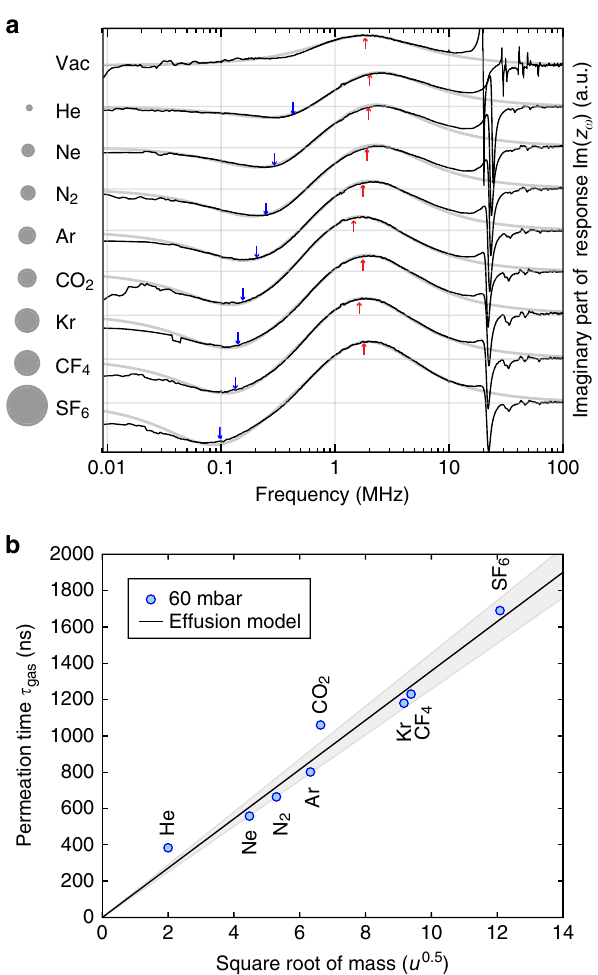
Fig. 3 Dependence of τ gas on gas molar mass. a Measurements performed in high vacuum and in various gases at P = 60 mbar on a micro drum with a 400 nm pore. Eq. (5) (grey line) is fi tted to the imaginary part of the measurement data (black line) and the red and blue arrows indicate the values obtained for τ th and τ gas , respectively. The areas of the circles represent the relative mass of the gas particles. b The permeation time τ gas increases linearly with the square root of the particle mass as predicted by Graham ’ s law. The black line shows a fi t of the measured values of τ gas to Eq. (1) with V / A = 2.71 ⋅ 10 − 6 ± 1.7 ⋅ 10 − 7 m. The 95% con fi dence interval is shaded grey.